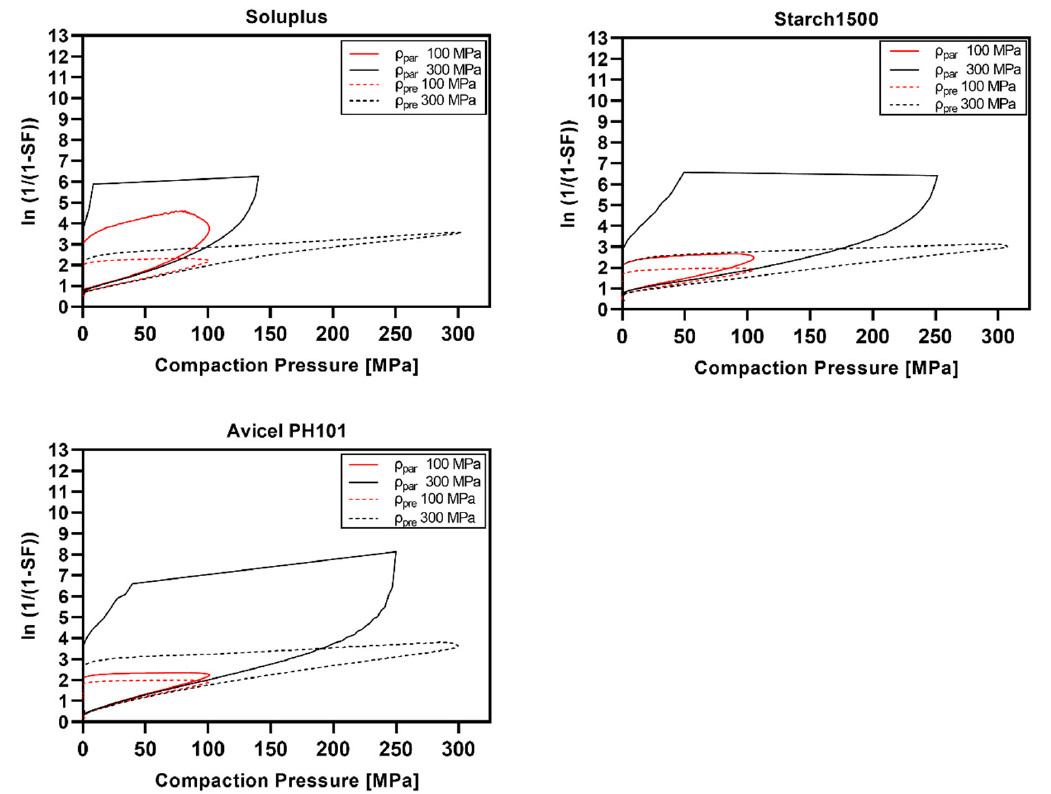
Figure 9. Heckel plots of polymeric excipients at 100 and 300 MPa calculated using particle density ( ρ par ) or density under pressure ( ρ pre ).